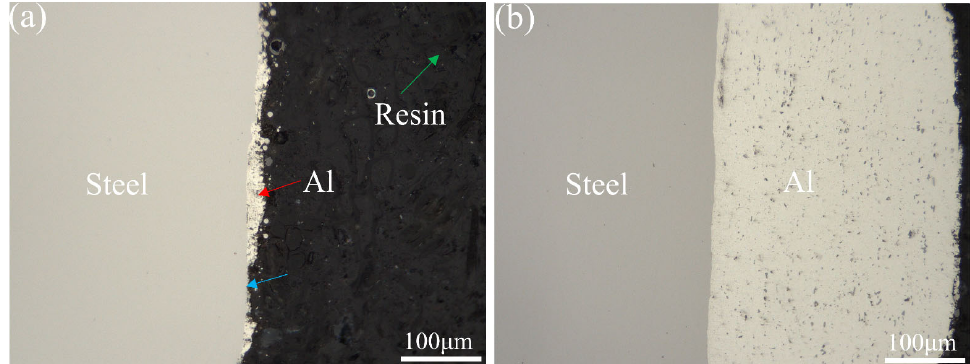
Figure 10. Cross section of tensile shear fracture: ( a ) initial sample and ( b ) aged sample.